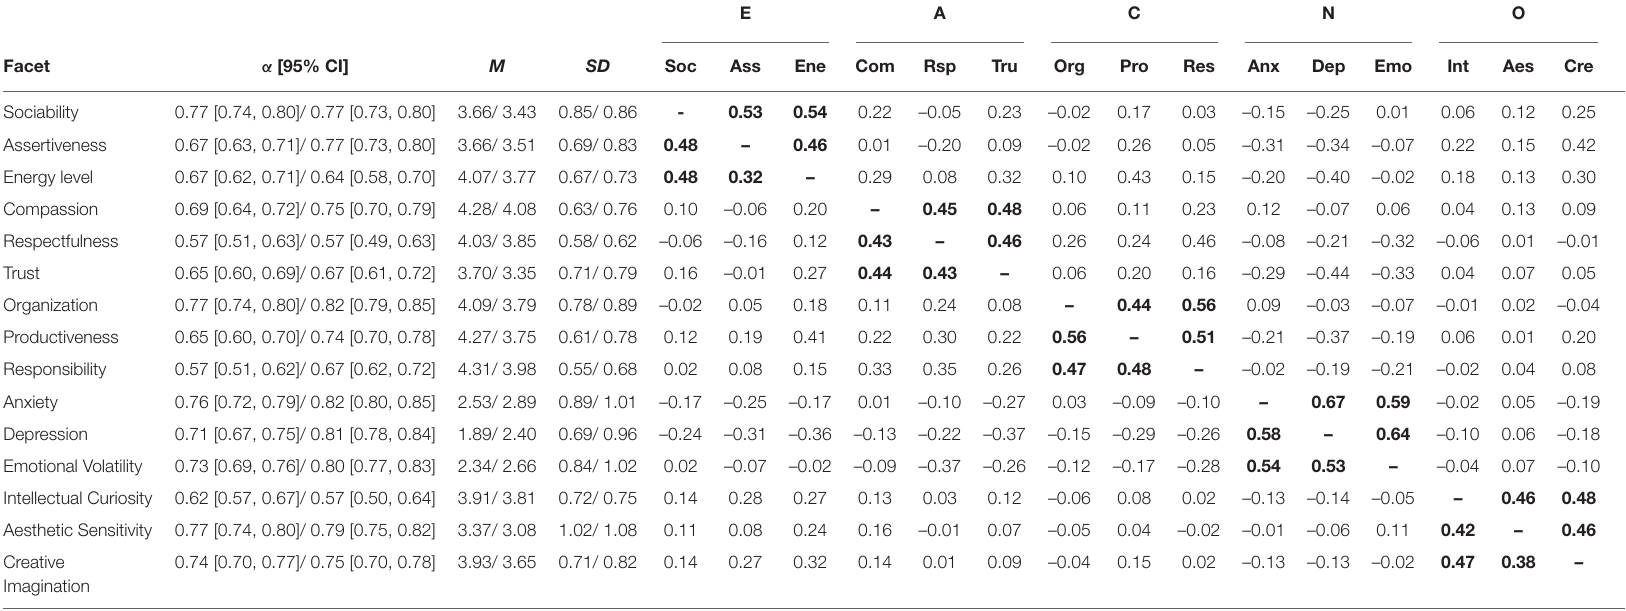
TABLE 4 | Reliability, descriptive statistics, and intercorrelations for scores from BFI-2 facets (Study 1 and